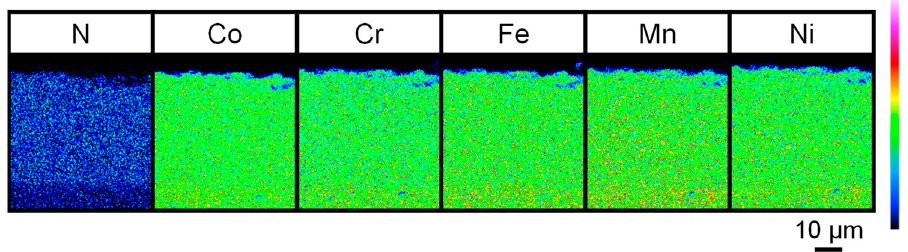
Figure 8. EPMA element mapping images of N, Co, Cr, Fe, Mn, and Ni for CoCrFeMnNi samples plasma-nitrided for 15 h at 773 K.